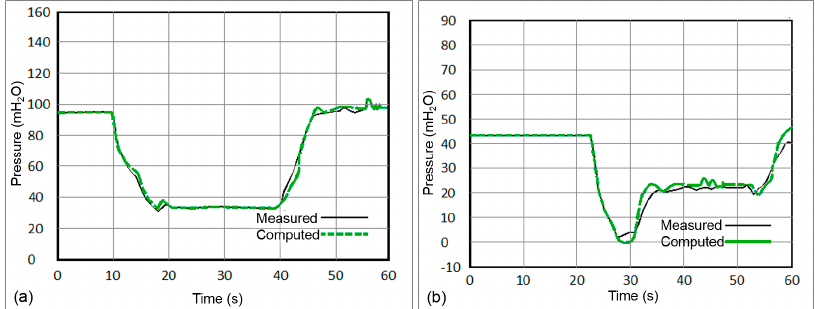
Figure 15. Measured and computed pressure traces ( a ) at discharge header of Pumping Plant 3 and ( b ) at the air valve located at station 54 + 560.